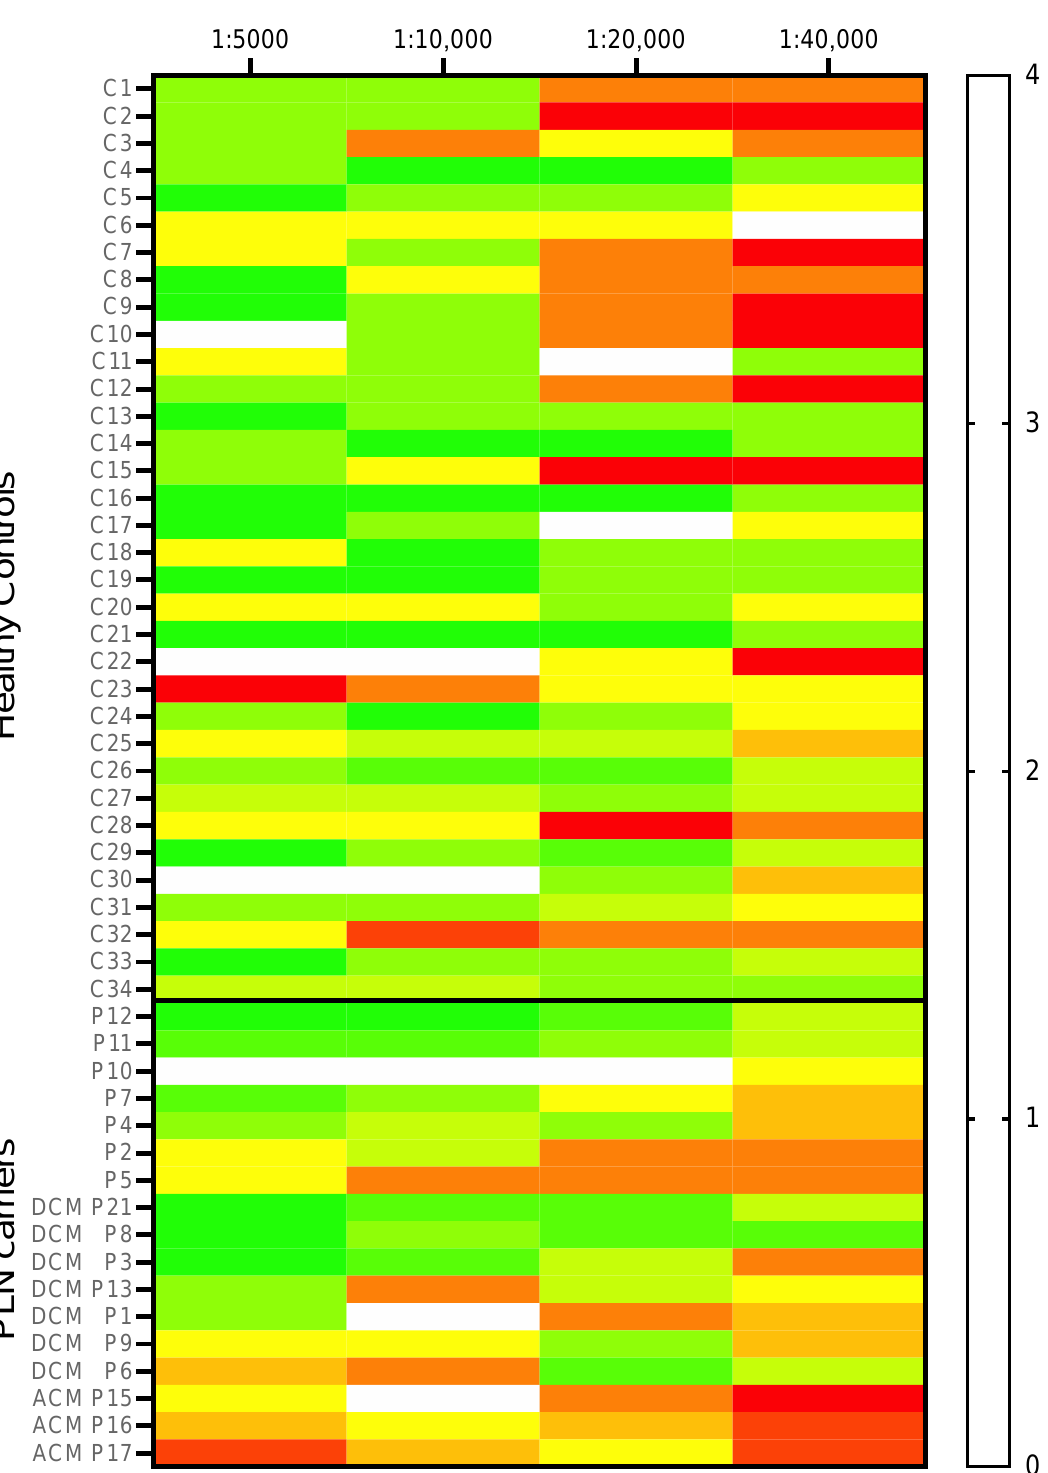
Figure 6. A heat map visualizing plakoglobin scores of all individual healthy controls ( n = 34) and PLN carriers ( n = 17), for all four dilutions. No clear difference was found between controls and PLN carriers in plakoglobin score. Colors correspond to score as shown in the right panel. At the left axis, controls (C) and PLN p.Arg14del patient (P) numbers are indicated. Furthermore, for PLN patients their clinical diagnosis is indicated when specified. PLN; phospholamban, ACM; arrhythmogenic cardiomyopathy, DCM; dilated cardiomyopathy.